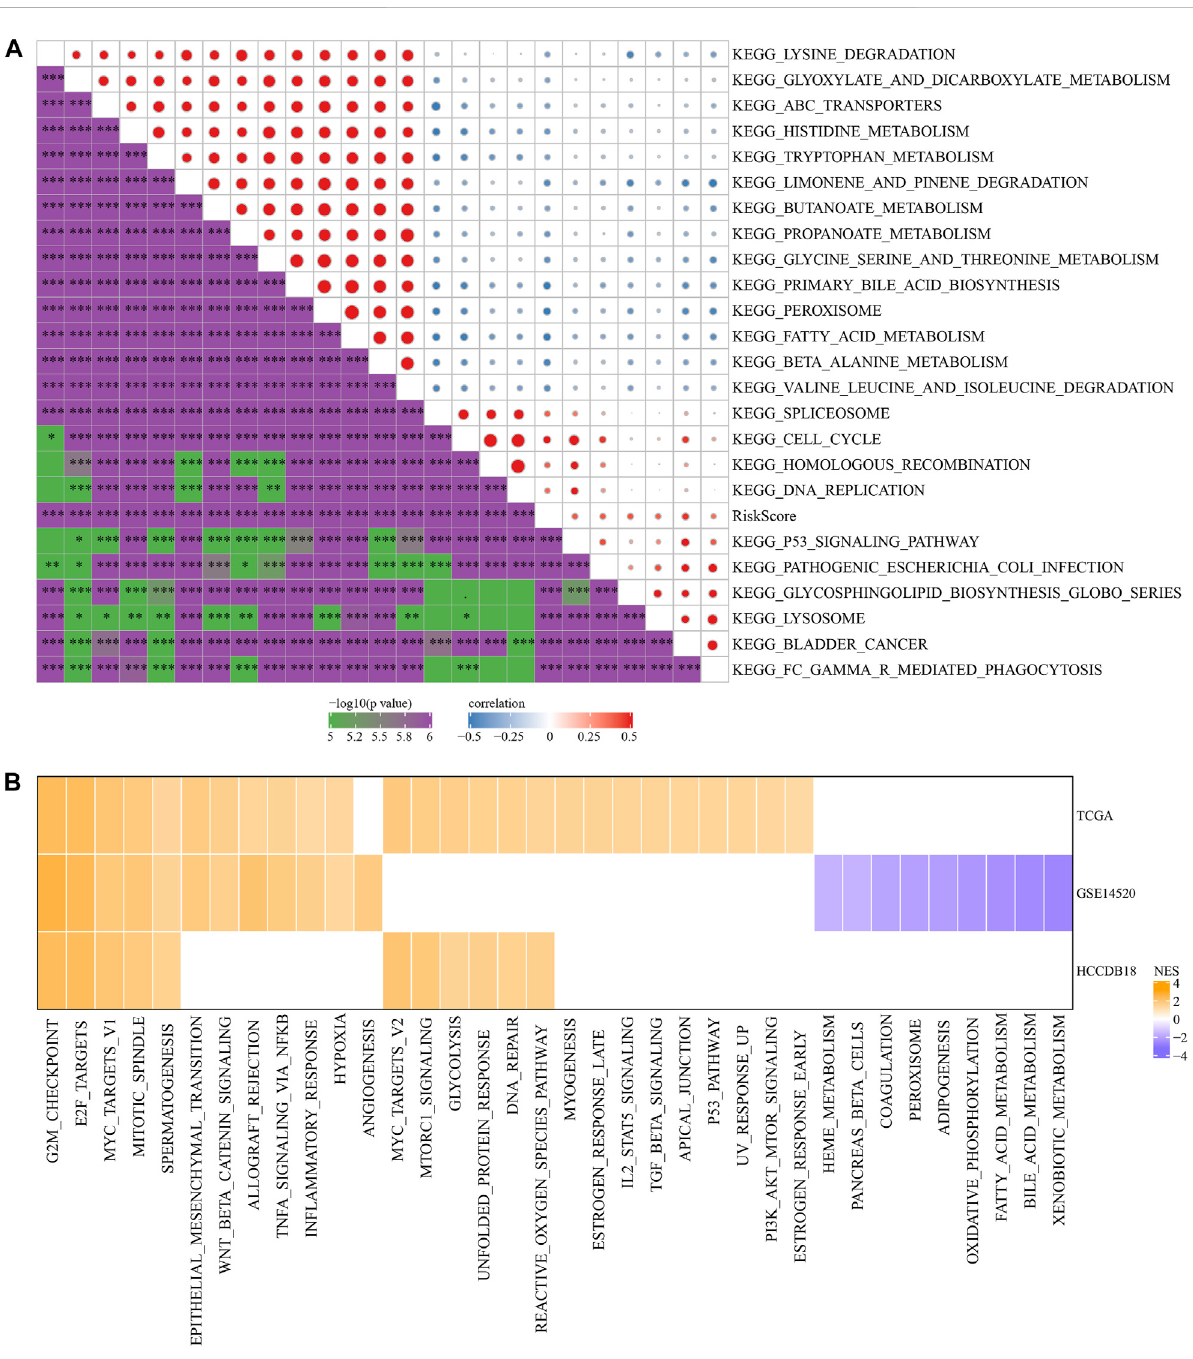
the RS-high group (2%), while that of LRRC7 in the RS-low group (1%) was lower when compared than the RS-high group (4%) (Figure 6A). Further distribution comparison of fraction altered, tumor mutation burden, homologous recombination